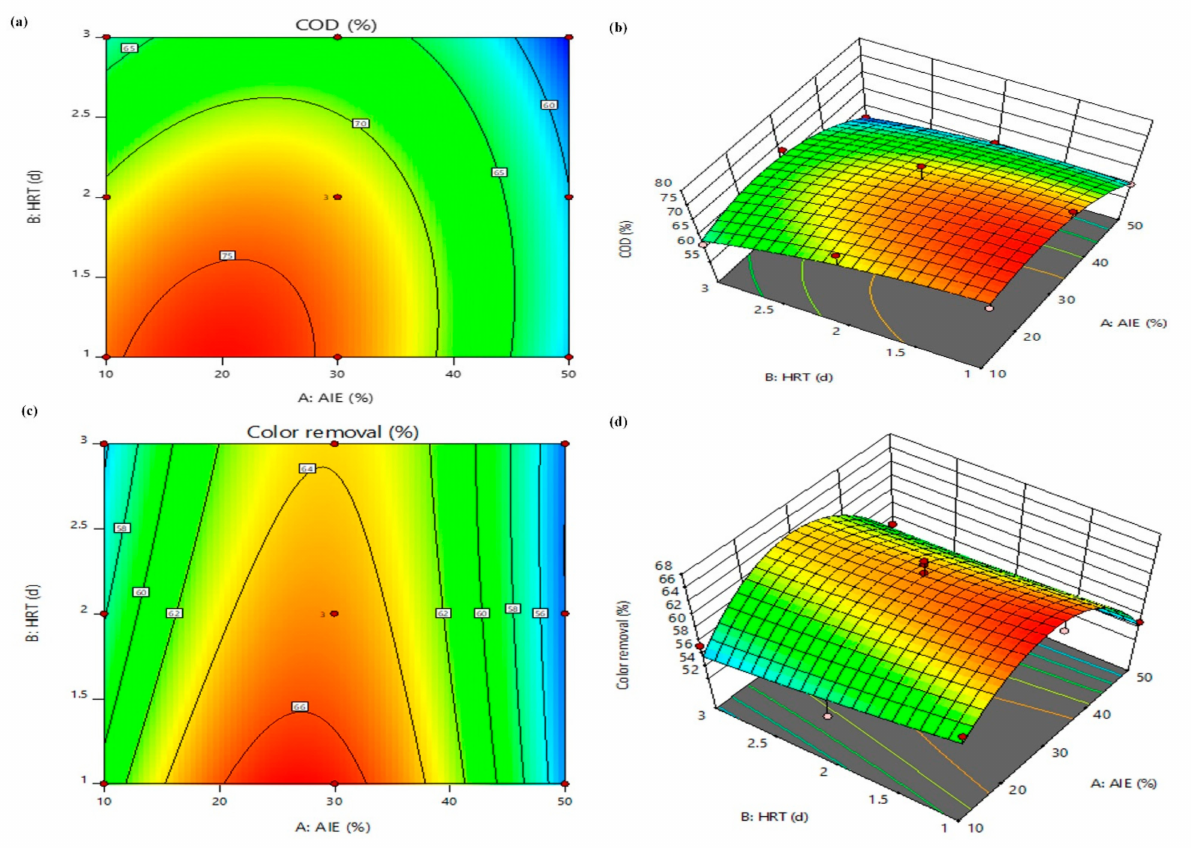
Figure 6. Contour and surface plot for the removal of ( a , b ) COD and ( c , d ) color from the CFBS